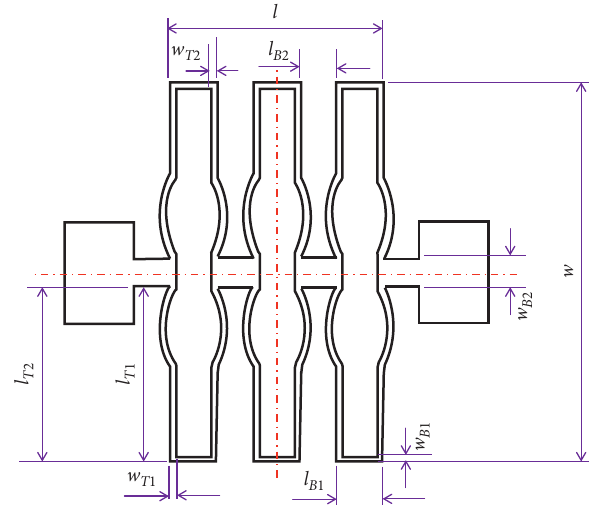
Figure 2: Geometrical dimensions of the TLET joint.